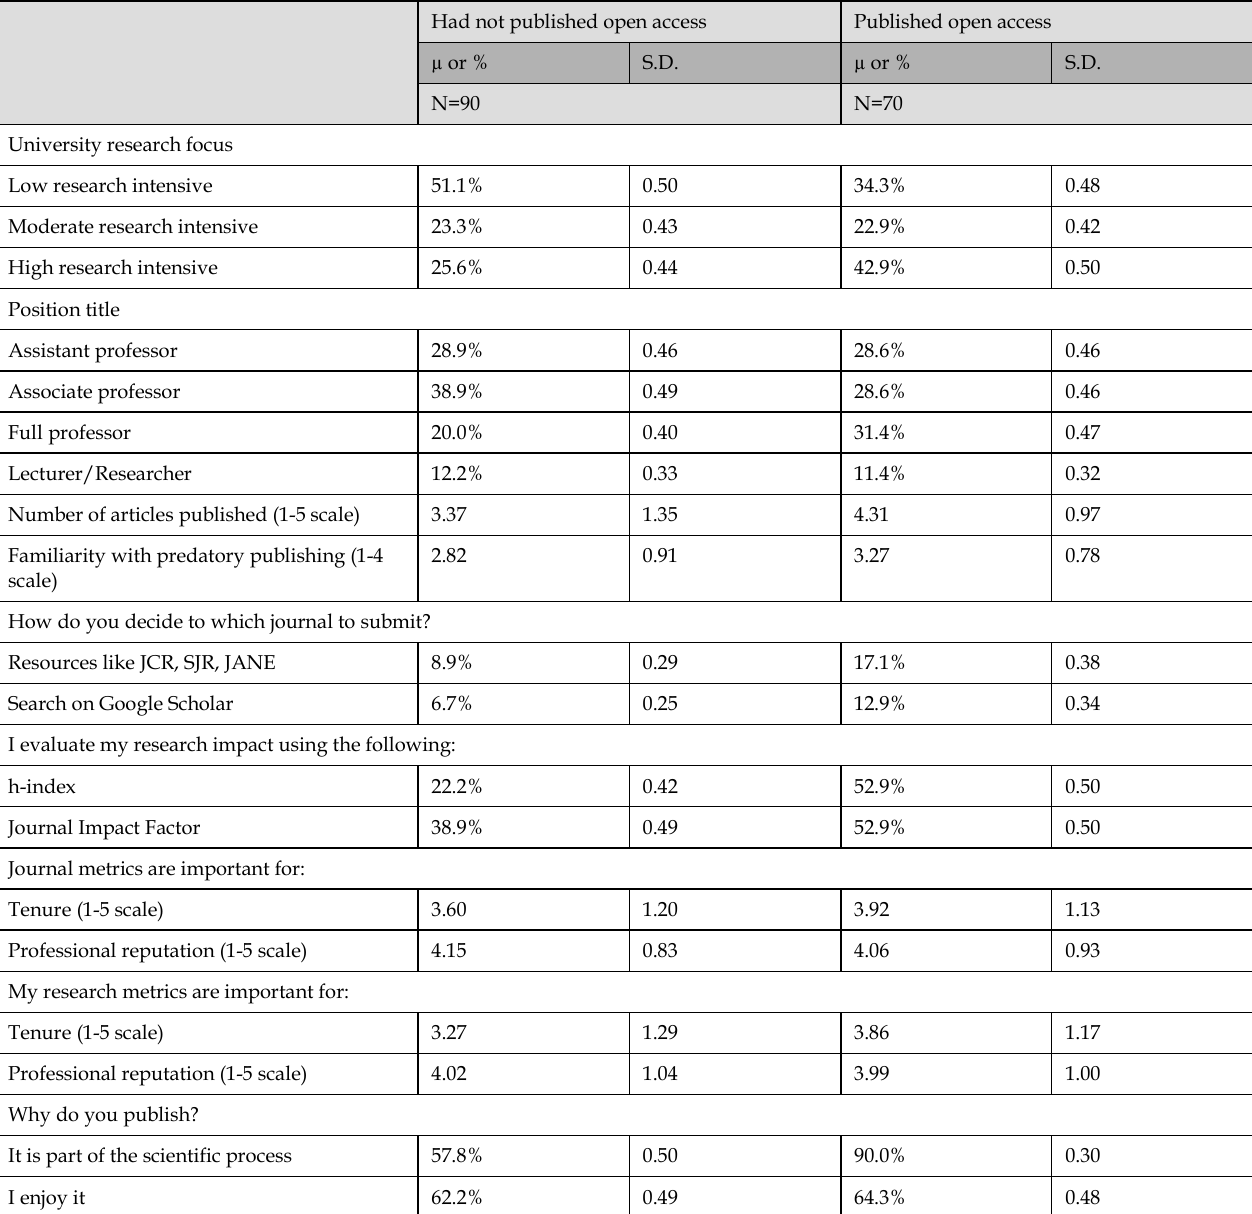
Table 3 Participant characteristics categorized by open access publishing record